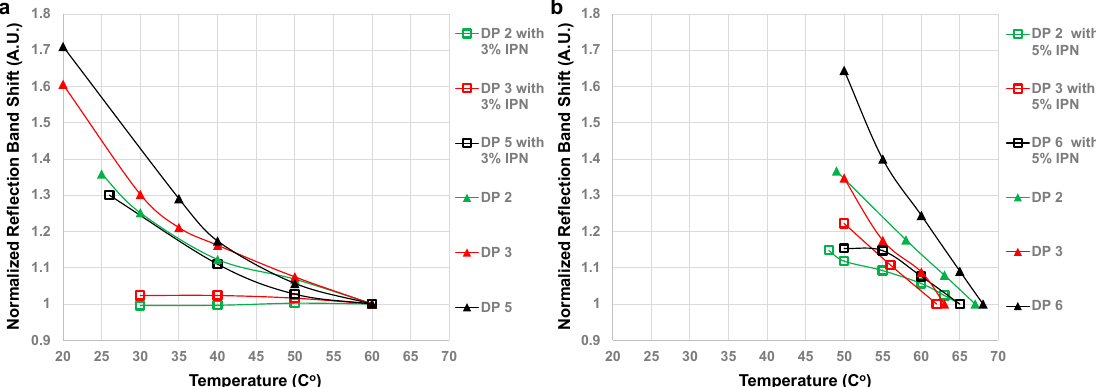
Figure 4. ( a ) Reflection band shift of oligomers containing no smectic monomer and 3 w% IPN as a function of temperature. The temperatures given were set on the heating stage; the sample temperatures might be slightly lower. ( b ) Reflection band shift of oligomers containing 25% smectic monomer and 5 w% IPN. The data were normalized by dividing all wavelength values by the wavelength value at the highest temperature to obtain the relative band shift.